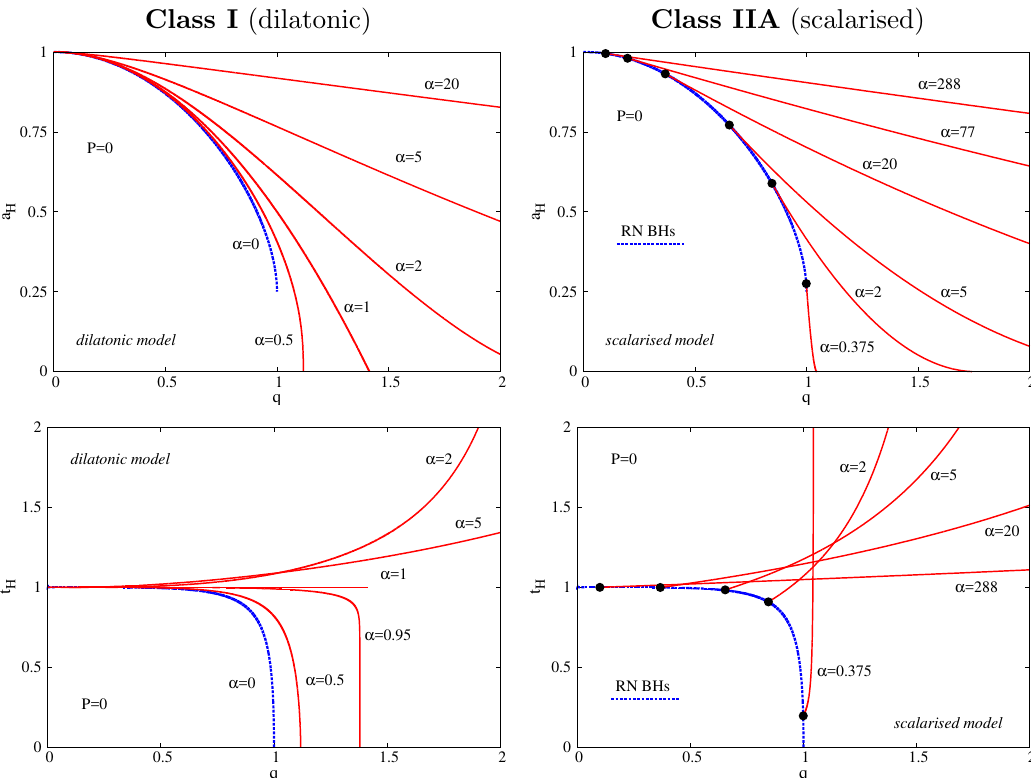
Figure 2 . Reduced area a H (top panels) and reduced temperature t H (bottom panels) vs. reduced charge q for dilatonic (left panels) and scalarised solutions (right panels). All solutions have P = 0. The blue lines are the set of RN BHs ( (cid:30) = 0). The red lines are sequences of BHs with a nontrivial scalar (cid:12)eld for a given (cid:11) . Di(cid:11)erent sequences are presented, for a range of values of (cid:11) . The black dots indicate the RN solutions from which the scalarised BHs